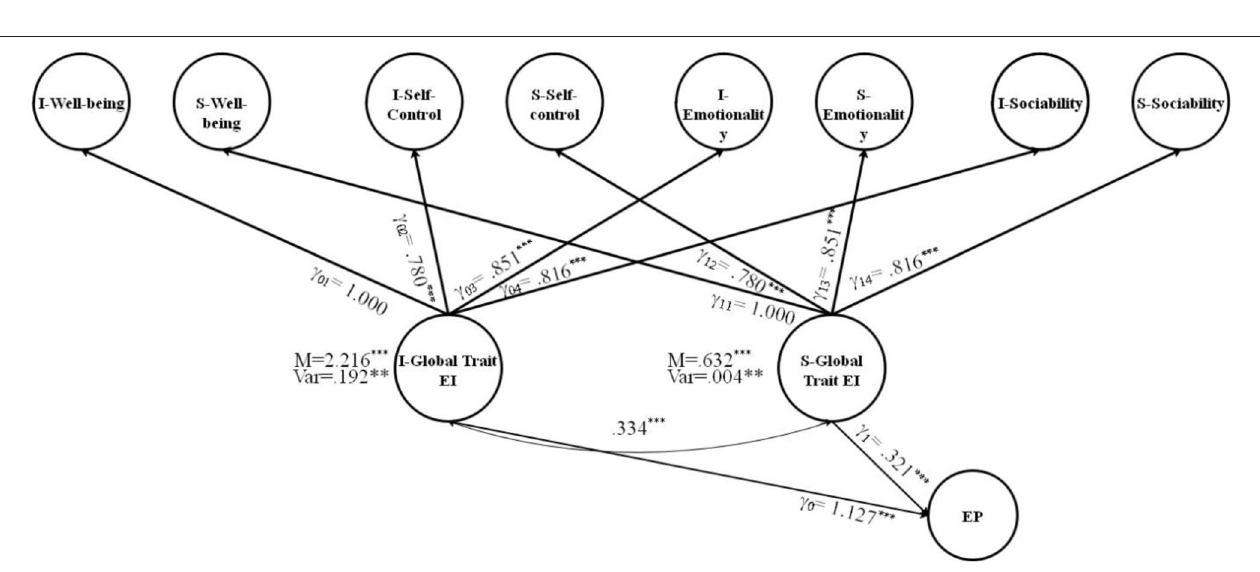
FIGURE 4 | FCM of TEI with the a latent predictor variable (EP). I, intercept; S, slope; TEI, trait emotional intelligence; WB, well-being; SC, self-control; EM, emotionality; SO, sociability; EP, emotion perception; M, mean; Var, variance; ε = error; γ = factor loading [ χ 2 (df) = 244.128 (98), p < 0.001; CFI/TLI = 0.974/0.963; RMSEA = 0.052; SRMR = 0.057]; *** p < 0.001 ; ** p < 0.01.